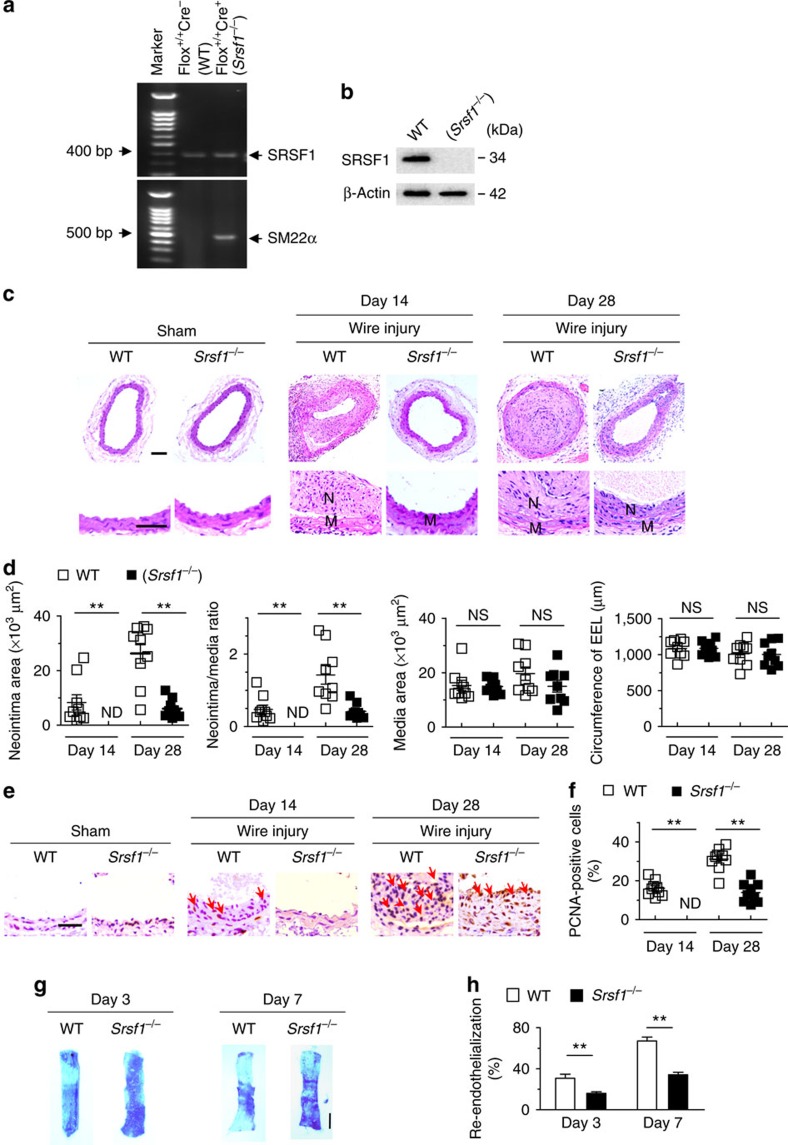
SRSF1 deficiency in VSMCs inhibits neointima formation.(a) PCR showing genotyping of WT (Flox+/+Cre−) and Srsf1−/− (Flox+/+Cre+) mice. Band in the upper image indicates the product from SRSF1flox/flox, and lower image indicates product from SM22α-Cre. (b) Representative western blots showing SRSF1 levels in vessel from smooth muscle cell-specific Srsf1 knockout (Srsf1−/−) mice. (c,d) Representative photomicrographs of haematoxylin and eosin staining (scale bars, 50 μm) (c) and averaged data (d) of the neointimal area, neointima/media ratio, media area and circumference of external elastic lamina (EEL) of carotid arteries from Srsf1−/− and WT control mice 14 and 28 days after wire injury (N, neointima; M, media); n=9 per group. (e,f) Representative photomicrographs of immunohistochemical staining (scale bar, 25 μm) (e) and averaged data (f) showing the percentages of PCNA-positive cells in carotid arteries from Srsf1−/− and WT control mice 14 and 28 days after wire injury. Arrows indicate PCNA-positive cells (dark brown); n=9 per group. (g,h) Representative pictures (g) and averaged data (h) of re-endothelialization. Re-endothelialization was quantified in Evans blue-stained carotid arteries at 3 and 7 days after vascular injury. Blue staining indicates endothelial denudation. Scale bar, 1 mm; n=9 per group. **P<0.01, NS, not significant; Student’s t-test (d,f,h). Data are mean±s.e.m. of five independent experiments (d,f,h).